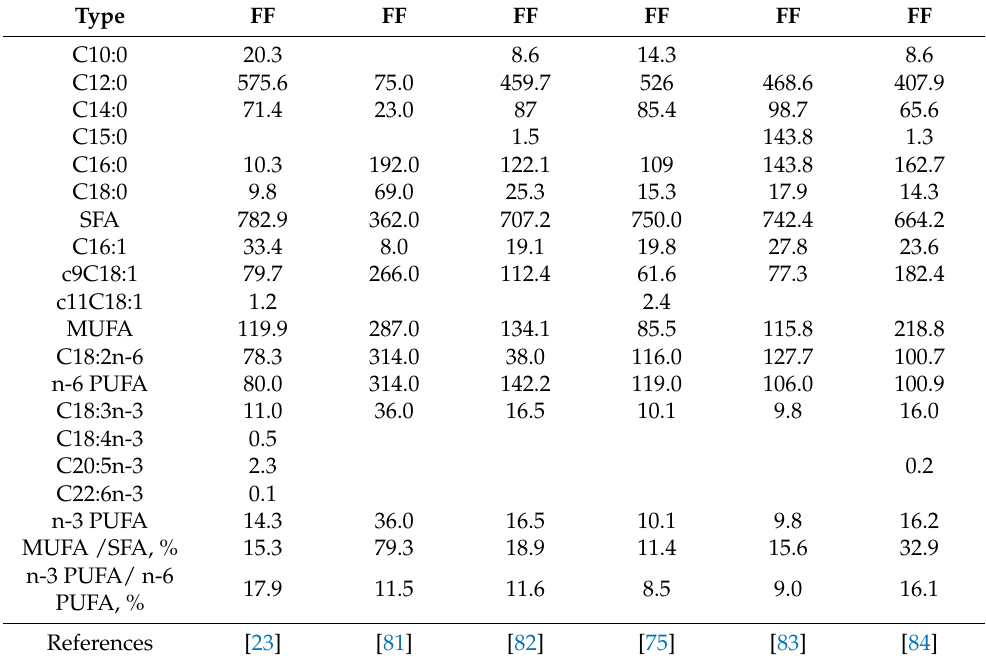
Table 3. Fatty acid composition of BSFL (g kg − 1 dry matter